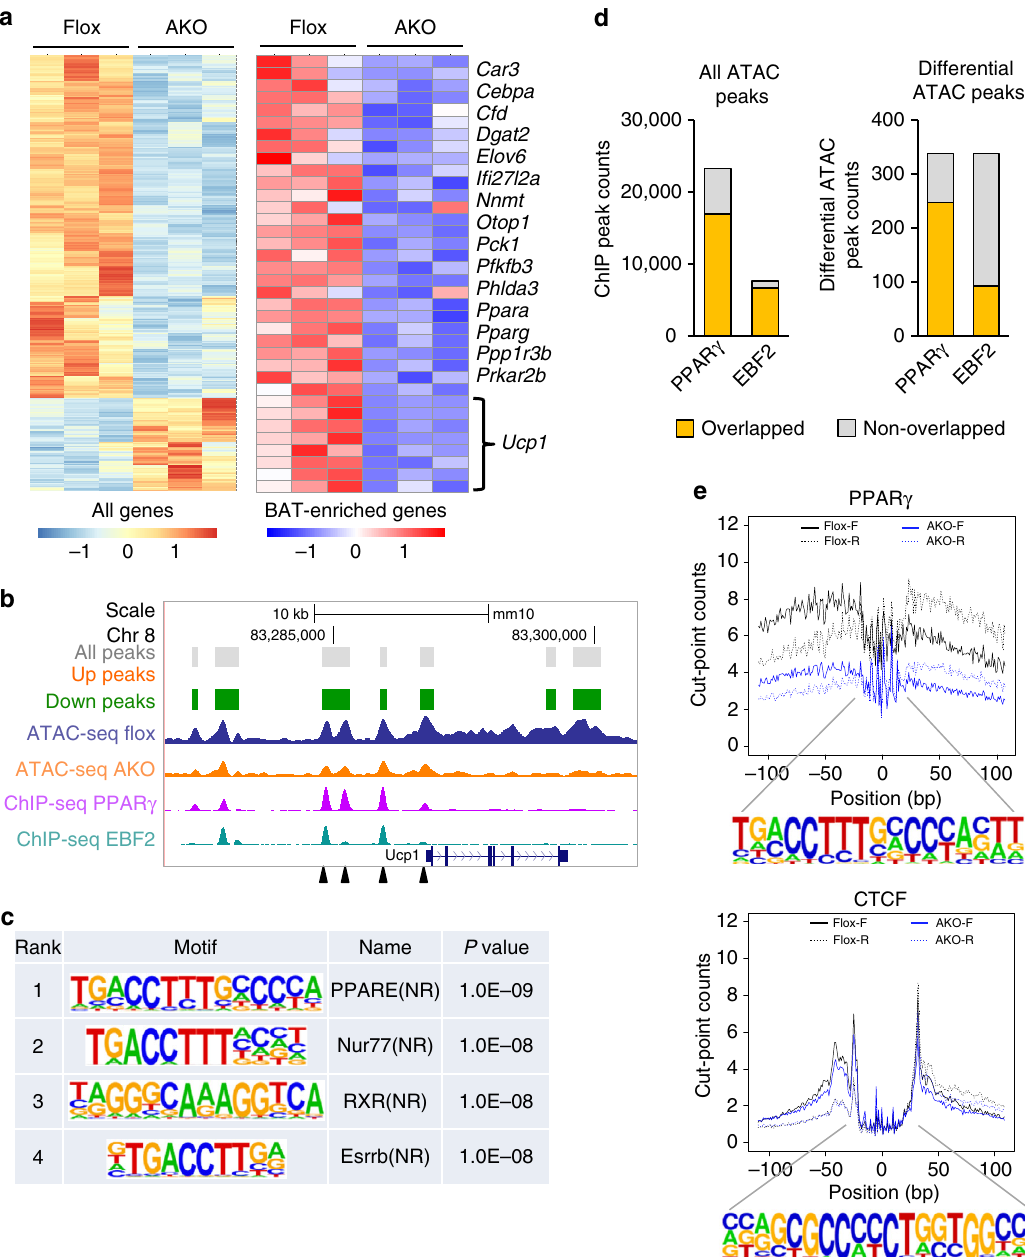
Fig. 2 Ablation of BAF60a disrupts chromatin accessibility in brown fat. ATAC-seq was performed on brown fat nuclei isolated from fl ox ( n = 3) and AKO ( n = 3) mice. a Heatmap representation of all differential peaks (left) or differential peaks near BAT-enriched genes (right). b UCSC genome browser view of chromatin structure at the Ucp1 locus. Mapped ATAC-seq peaks correspond to all peaks and those up- or down-regulated following BAF60a inactivation. ATAC-seq traces for Flox and AKO brown fat (middle) and the ChIP-seq peaks for PPAR γ and EBF2 (bottom) were shown. Arrowheads indicate the locations for PPAR γ ChIP qPCR primers. c Motif-enrichment analysis of the down-regulated peaks in AKO brown fat. d Overlaps of PPAR γ and EBF2 ChIP binding peaks within all ATAC-seq peaks (left) or differential ATAC-seq peaks (right). e Footprint aggregate plots at putative PPAR γ and CTCF binding sites. Source data are provided as a Source Data fi